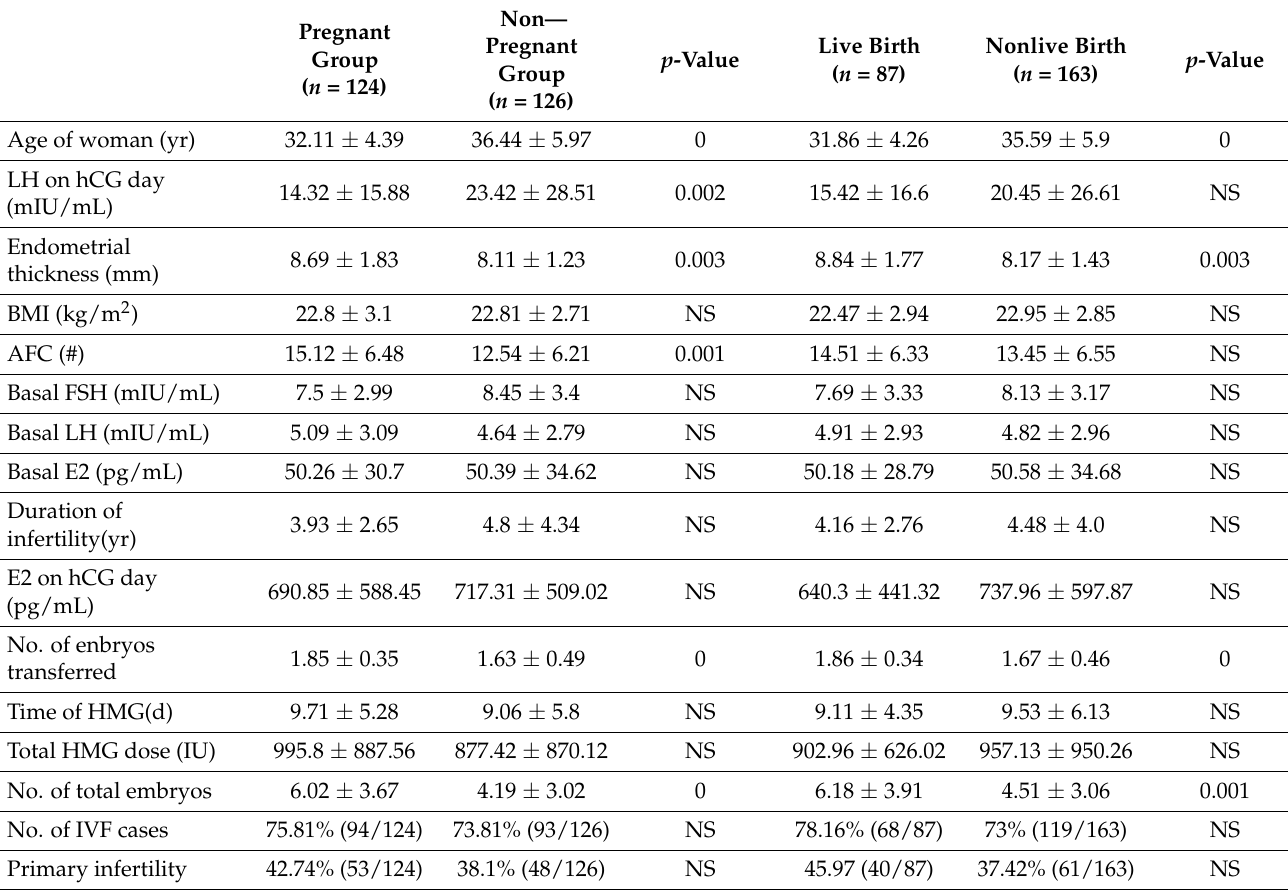
Table 2. Patient and cycle characteristics by pregnancy outcome.